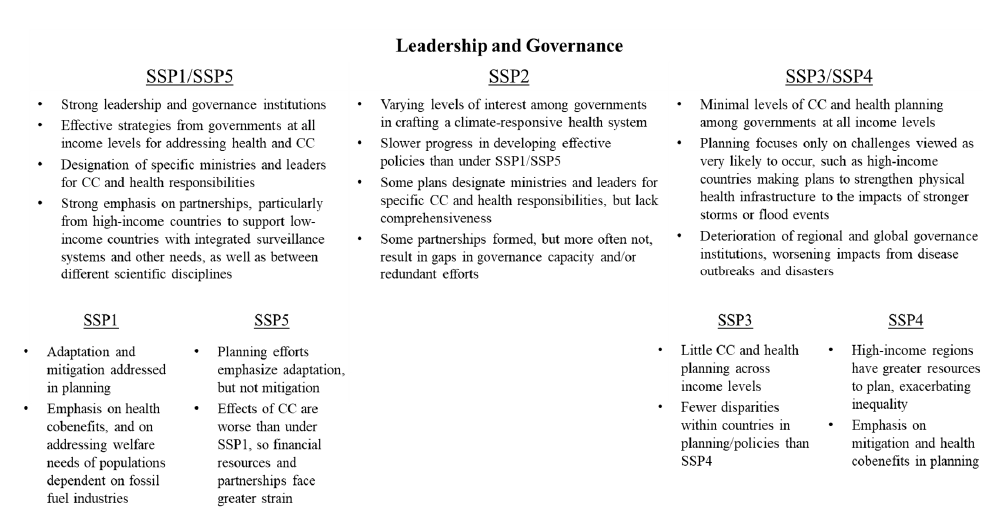
Figure 3. Variation in health system leadership and governance conditions across SSPs.